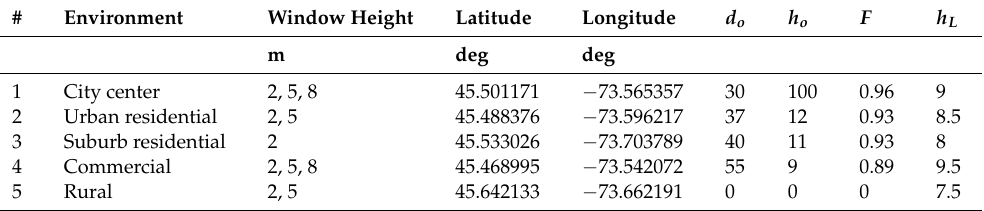
Figure 7. The azimuth angle of a window facing the nearest street derived from the street network. This figure is for a small part of Montréal centred on site #2 of Table 3. The white star marker indicates the position of site #2. Table 3. List of modelled